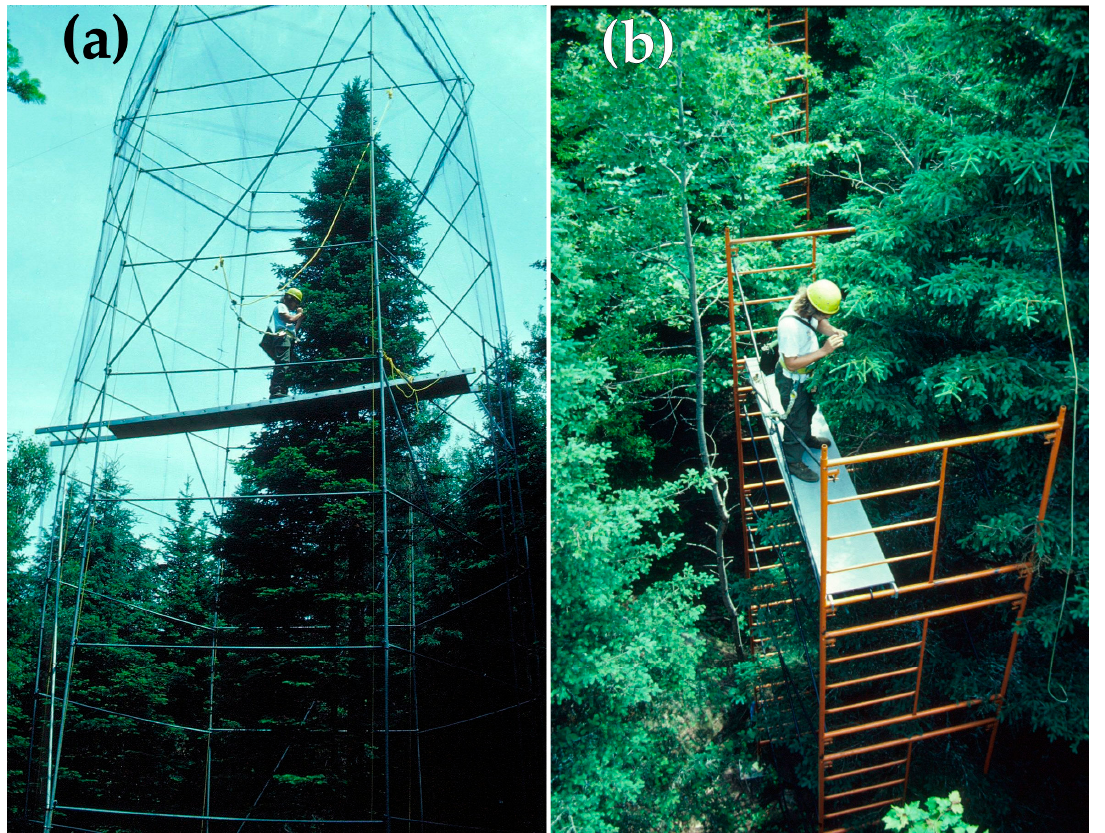
Figure 2. Implanted budworm cohort observations being recorded at mid-crown on mature white spruce trees in Armagh in 1987. ( a ) Inside a bird exclosure cage. ( b ) On scaffolding.